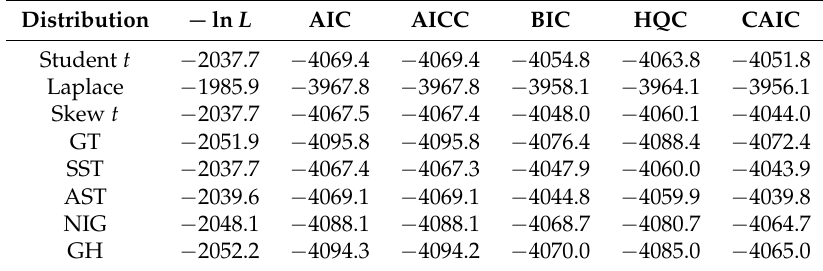
Table 6. Fitted distributions and results for daily log returns of the exchange rates of Dogecoin from